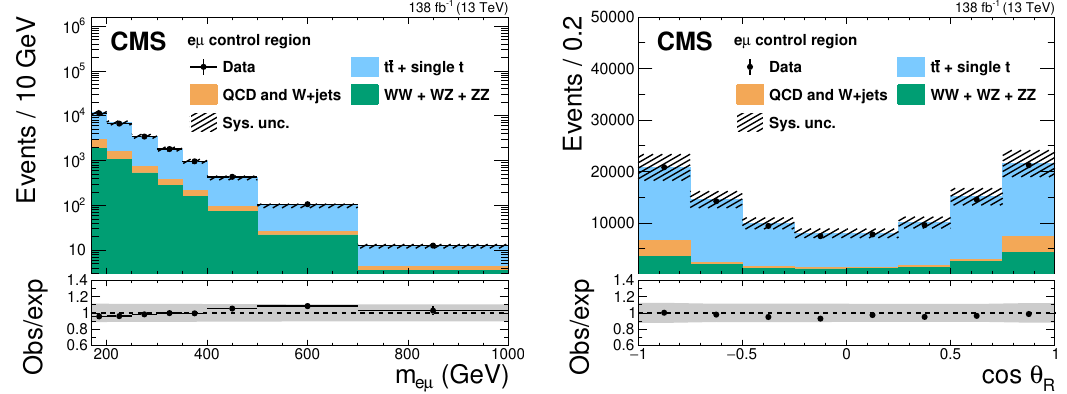
distribution (right) of e m events ob- Figure 1 . The invariant mass distribution (left) and cos θ R served in CMS data (black dots with statistical uncertainties) and expected backgrounds (stacked histograms). The hatched bands show the systematic uncertainty in the expected yield. The sources of this uncertainty are discussed in section 8. The lower panels show the ratio of the data to the expectations. The gray bands represent the total uncertainty in the predicted